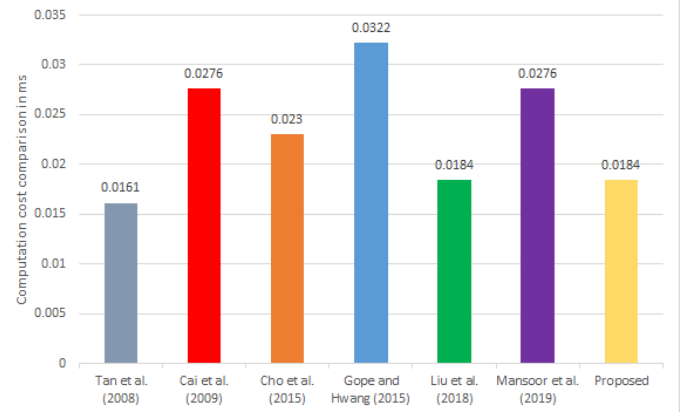
Figure 2. Comparison of the computational cost.